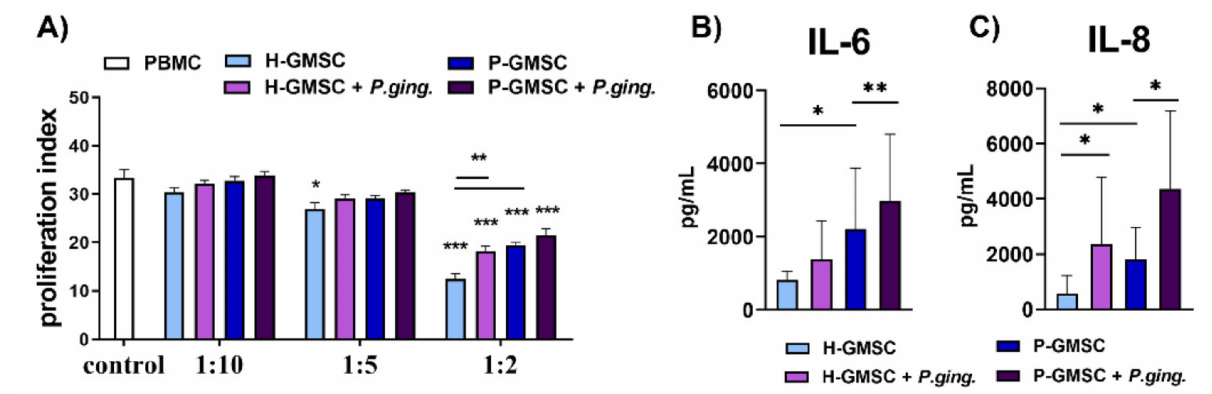
Figure 4. ( A ) Effect of untreated or P. gingivalis treated GMSC lines on PBMC proliferation. The co-culture experiments using different GMSC: PBMC ratios (1:10; 1:5; and 1:2) are described in detail in Materials and methods. Values are given as the mean proliferation index ± SD of four different experiments. * p < 0.05; *** p < 0.001 compared with control. ** p < 0.01 compared with corresponding cultures as indicated by bars. ( B , C ) Effect of P. gingivalis on the production of IL-6 and IL-8 by GMSC lines. The lines were stimulated with P. gingivalis for 24 h as described in Materials and methods. Untreated lines served as controls. Values are given as mean concentrations of cytokines in supernatants ± SD ( n = 7–9). * p < 0.05; ** p < 0.01 compared with corresponding controls as indicated by